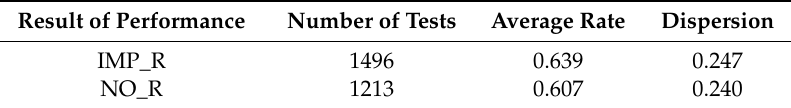
Table A4. Numerical results of the users regarding the camera rotation groups. Result of Performance